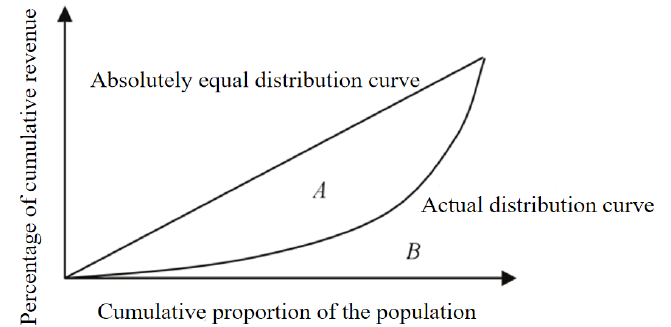
Figure 1. Schematic diagram of Lorentz curve. A is the area between the actual distribution curve and the absolute equal distribution curve; B is the area under the actual distribution curve.